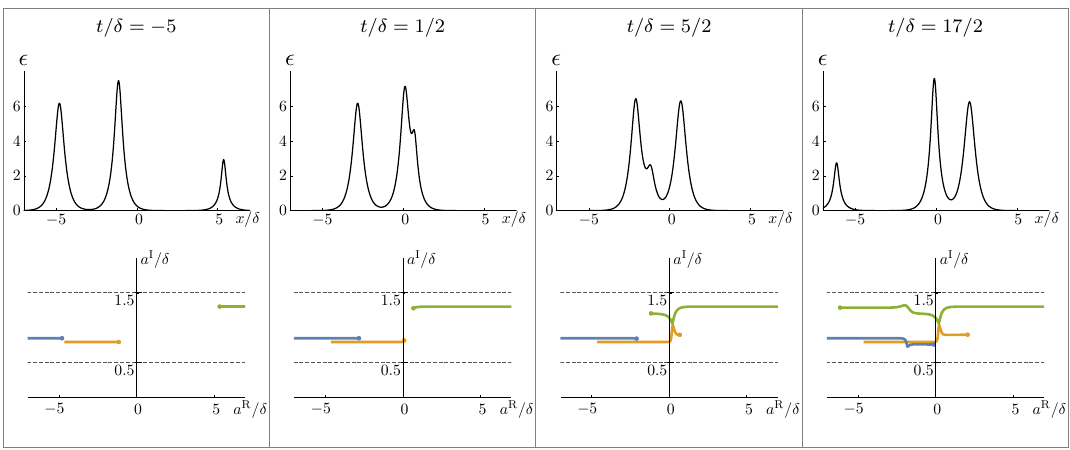
Figure 4 . Time evolution of the three-soliton solution with initial data (6.36) II: energy density and location of poles at four instances of time t . At each time t , the energy density (cid:15) ( x, t ) (first row) and poles a j ( t ) = a R ( r ) + i a I ( t ) (blue, orange, and green dots for j = 1 , 2 , 3 at t = j j in the second row) are shown. The plots visualize two soliton collisions: the first between j = 2 and j = 3 at time t/δ 1 . 03 and the second between j = 1 and j = 3 at time t/δ ≈ in the last paragraph of section 6.4, the assignment of poles to solitons can be swapped in soliton collisions, and the colors blue, orange, and green distinguish different solitons, i.e., the same color means the same